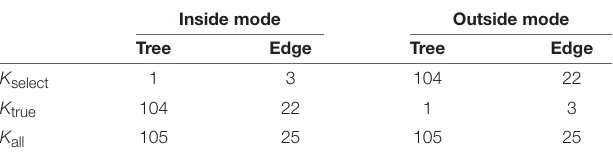
TABLE 3 | The number of regions for trees and edges. The number of taxa is N = 6. Inside mode Outside mode Tree Edge